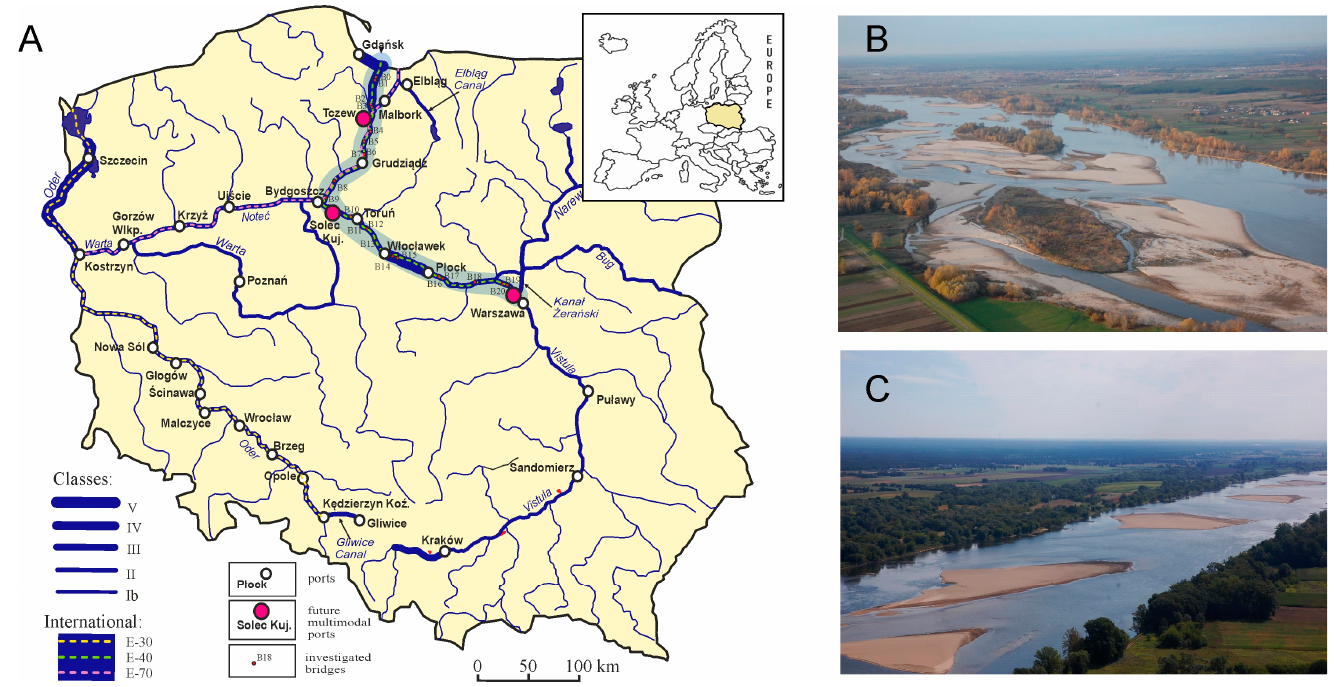
Figure 1. The study area—of the Vistula waterway between Gda ń sk and Warsaw: ( A )—map of inland waterways in Poland, ( B )—the Vistula riverbed near Warsaw, ( C )—the Vistula River between Toru ń and Bydgoszcz (photo ( C )– D . Szatten, photo ( B )—M. Habel). Table 1. Gauging stations on the Vistula waterway from Gda ń sk to Warsaw.